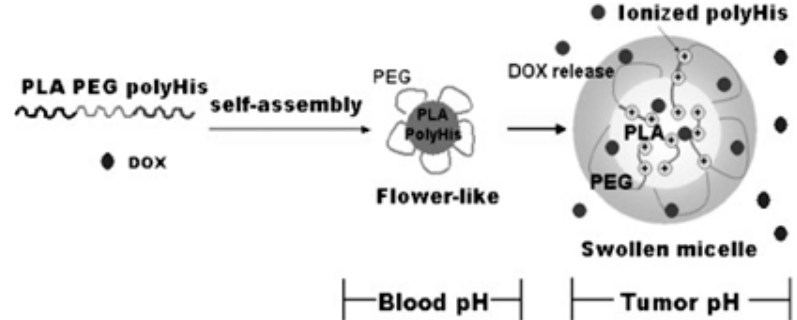
Figure 4. Schematic representation of formation of flower like micelle from poly( L -lactic acid)- b -poly(ethylene glycol)- b -poly( L -histidine) and triggered release of drugs in tumor pH by re-self-assembly. Reproduced with permission from [71]. Copyright 2007, Elsevier.